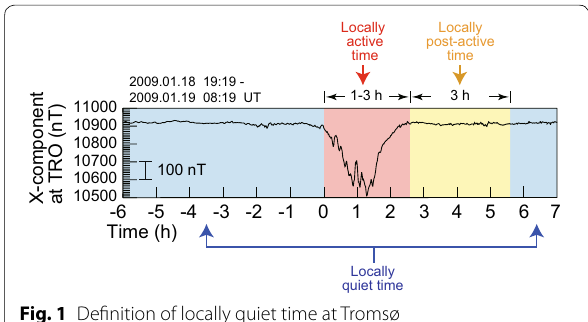
Fig. 1 Definition of locally quiet time at